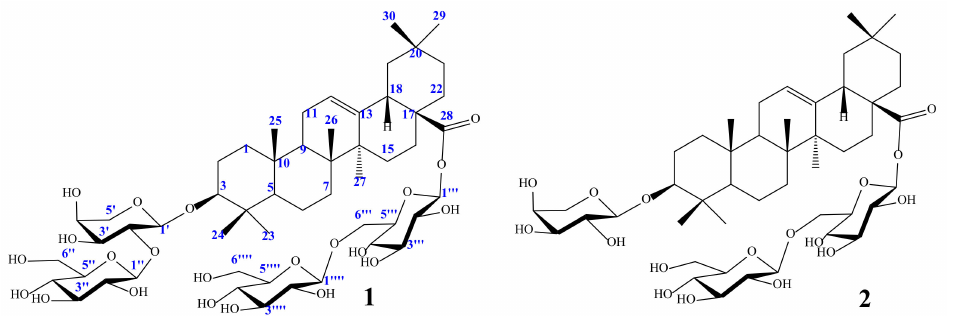
Figure 1. The structure of the isolated compounds 1 and 2